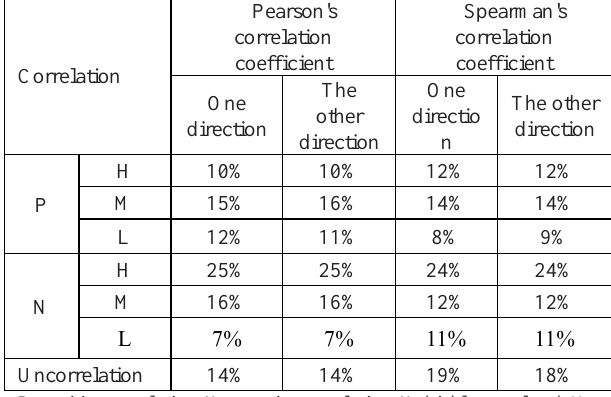
Table 1. Results of T test for urban roads in Shenzhen city